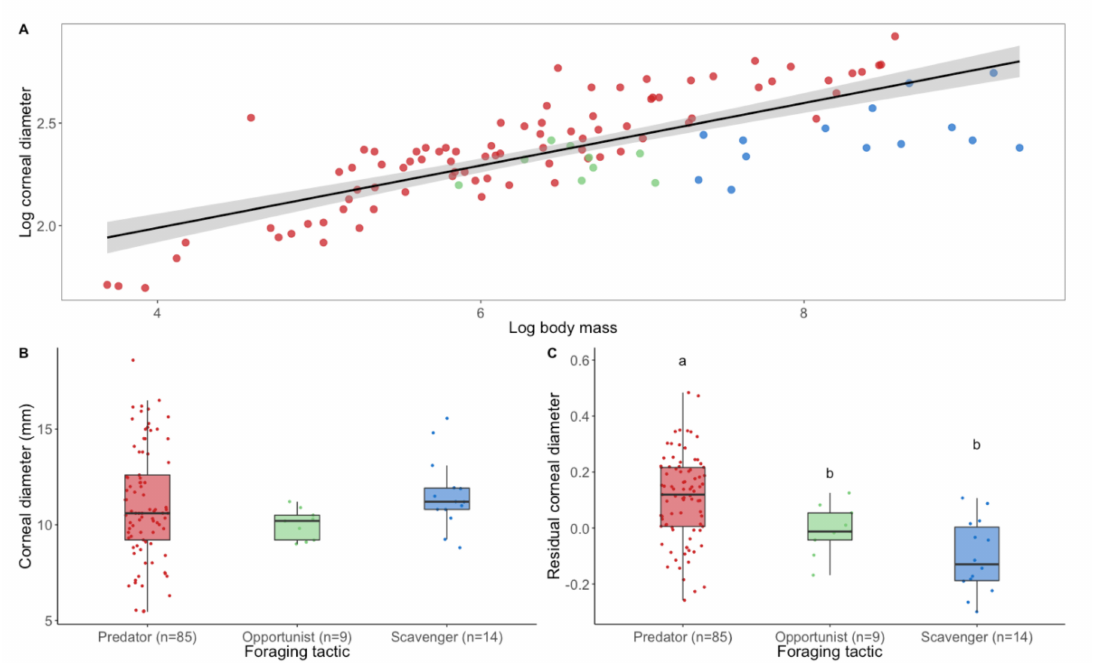
Figure 3. The eye size of raptors according to their foraging tactic. ( A ) Logarithmic relationship (black line) and 95% confidence level interval (grey shade) between corneal diameter (a proxy for eye size) and body mass in raptors (estimate = 0.14 ± 0.01, t = 9.48, p < 0.001). ( B ) Corneal diameter and ( C ) residual corneal diameter calculated from corneal diameter scaled to body weight in relation to foraging tactics. Di ff erences among foraging tactic were tested using phylogenetic linear regression. The phylogenetic relationships among 130 species were estimated using a consensus tree based on 100 randomly selected trees from www.BirdTree.org [11] using Ericson tree distribution. Data were analysed on R 4.0.0 using ggplot2 [31], phylolm [32], phytools [33], caper [34], lmtest [35], ggpubr [36], and plyr [37]. Edge lengths were obtained by computing the mean edge length for each edge in the consensus tree. Model selection based on AICc and likelihood ratio test (lrtest function from lmtest package [35]) showed no di ff erences for corneal diameter among foraging tactics (Chisq = 0.52, p = 0.77). By contrast, a significant di ff erence was found for residual corneal diameter among foraging tactics (Chisq = 24.47, p < 0.001). Predators have significantly larger eyes compared with their body mass than opportunists (estimate = − 0.11 ± 0.05, t = − 2.20, p = 0.03) and scavengers (estimate = − 0.21 ± 0.04, t = − 4.90, p < 0.001). Scavengers and opportunists do not di ff er (estimate = − 0.09 ± 0.06, t = − 1.50, p = 0.14). Dots represent species. Di ff erent colours represent di ff erent foraging tactics (red = predator, green = opportunist, blue = scavenger). Di ff erent letters represent significant di ff erence. Body mass were taken from [38] and corneal diameters from [27,39–41]. (Boxplots: black lines represent the median, coloured boxes represent the interquartile (IQR) range from 25th (Q1) to 75th (Q3) percentile, whiskers represent Q1 − 1.5 * IQR and Q3 + 1.5 * IQR). Note: for foraging tactics classification, please refer to Supplementary Table